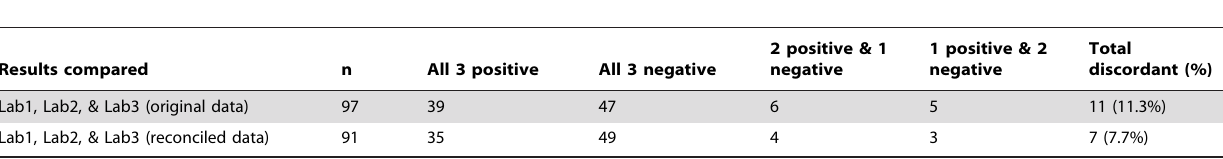
Table 2. Summary comparisons of QuantiFERON-TB Gold In-Tube test interpretations performed on the same subjects in three labs.